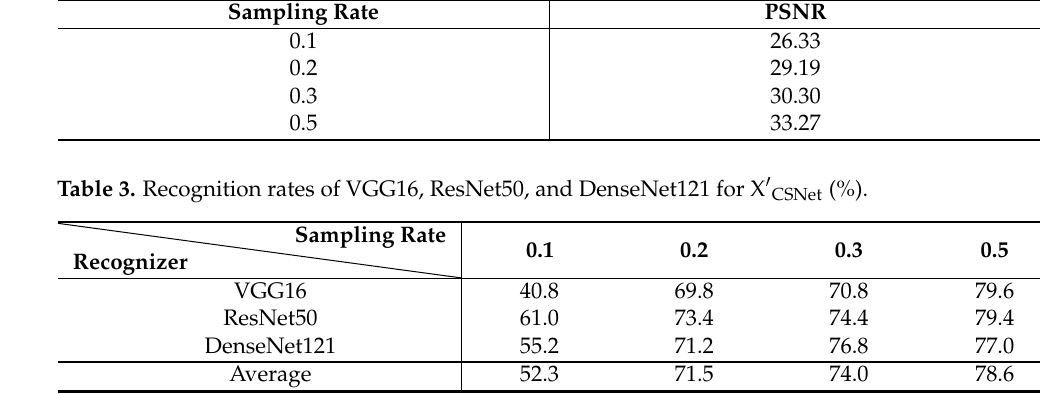
Table 2. Evaluating image quality of X (cid:48) CSNet in terms of PSNR (dB).